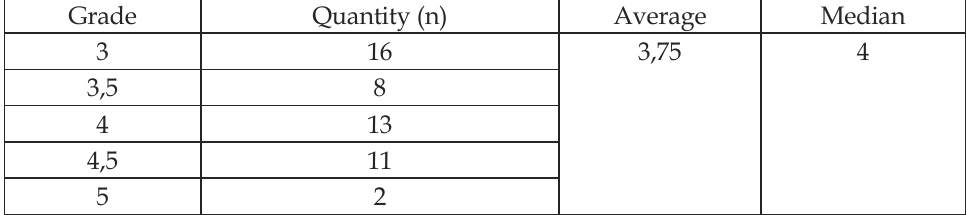
Table 7 . Average grade pro (cid:222) le of students. Grade Quantity (n) Average Median 3 16 3,75